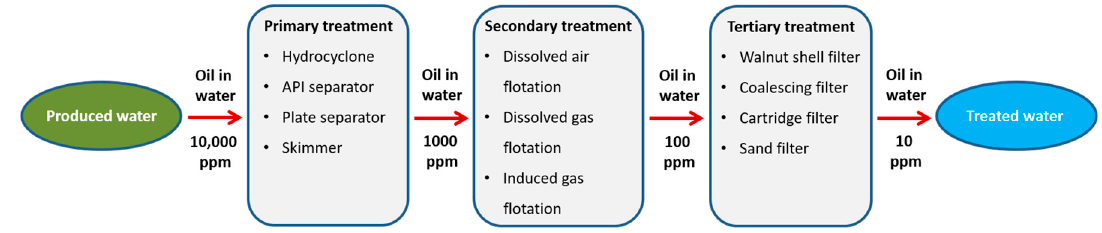
Figure 1. Schematic illustration of various treatments for oil/water separation.